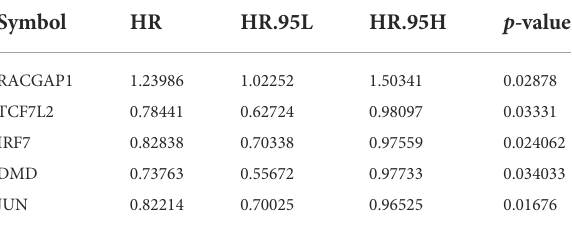
TABLE 1 Univariate Cox proportional hazards regression analysis of COVID-19 combined with BRCA gene. Symbol HR